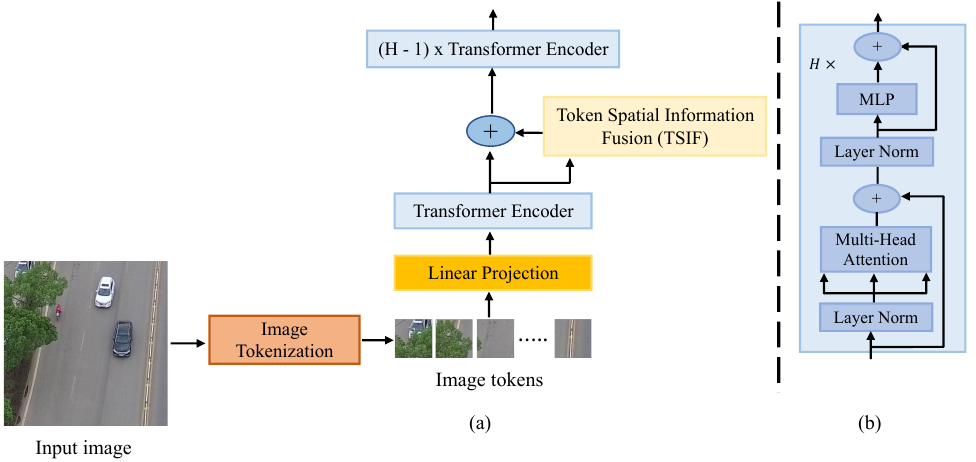
Figure 2. ( a ) Overview of an encoder network design. It consists of linear projection, transformer encoder, and Token Spatial Information Fusion (TSIF) modules. ( b ) Transformer encoder